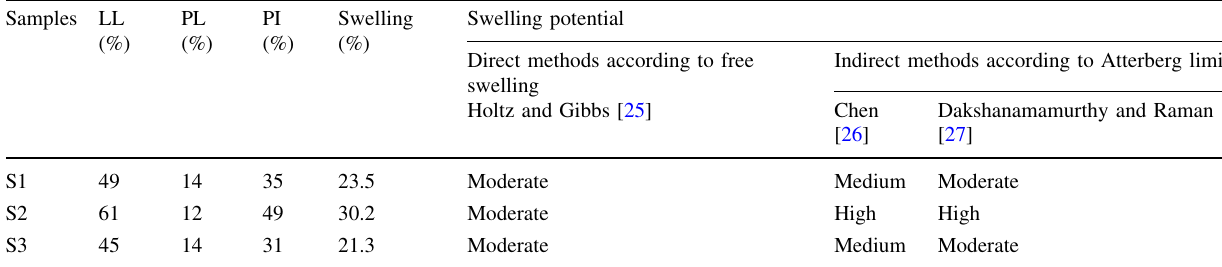
Moderate Medium